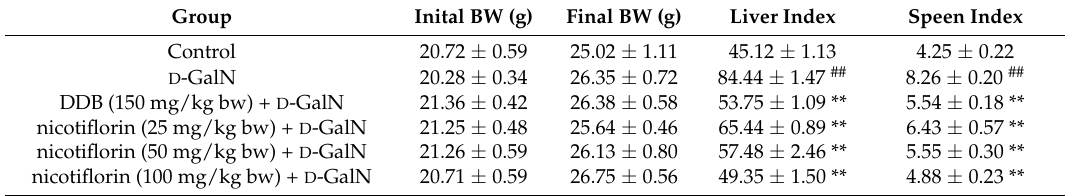
nicotiflorin (100 mg/kg bw) + D -GalN Values are mean ± S.E.M., n = 10. ## p < 0.01 compared with the control group. ** p < 0.01 compared with the Con A group. BW, body weight.